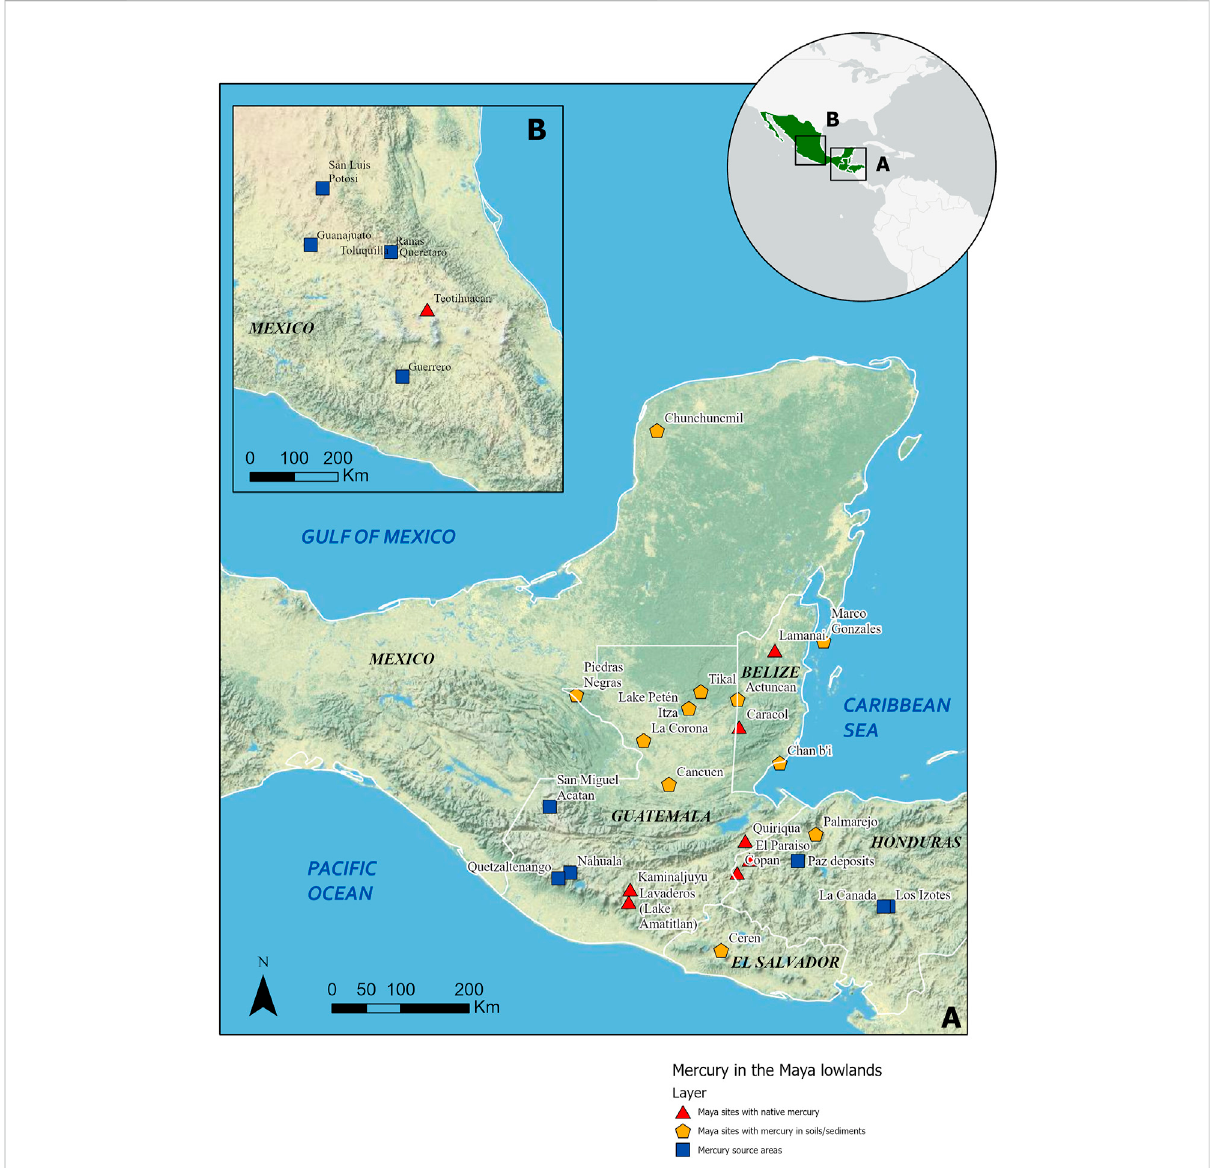
FIGURE 4 The Maya world and broader Mesoamerica region, encompassing Mexico, Guatemala, Belize and parts of Honduras and El Salvador, showing locations of sites discussed in this paper. Map prepared by Anaïs Zimmer using the National Geographic World Map (2011) in ArcGIS Pro.